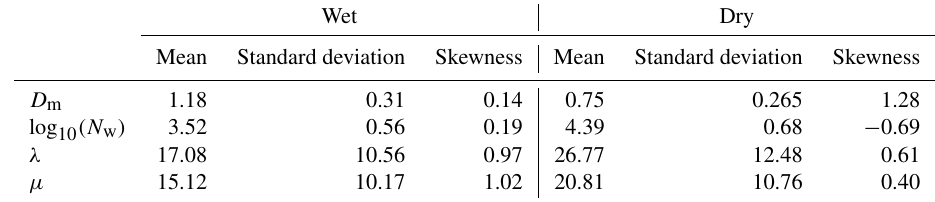
Table 2. Mean, standard deviation, and skewness of the DSD parameters in wet and dry spells. Wet Dry Mean Standard deviation Skewness Mean Standard deviation Skewness D m 1.30 0.38 log 10 (N w )